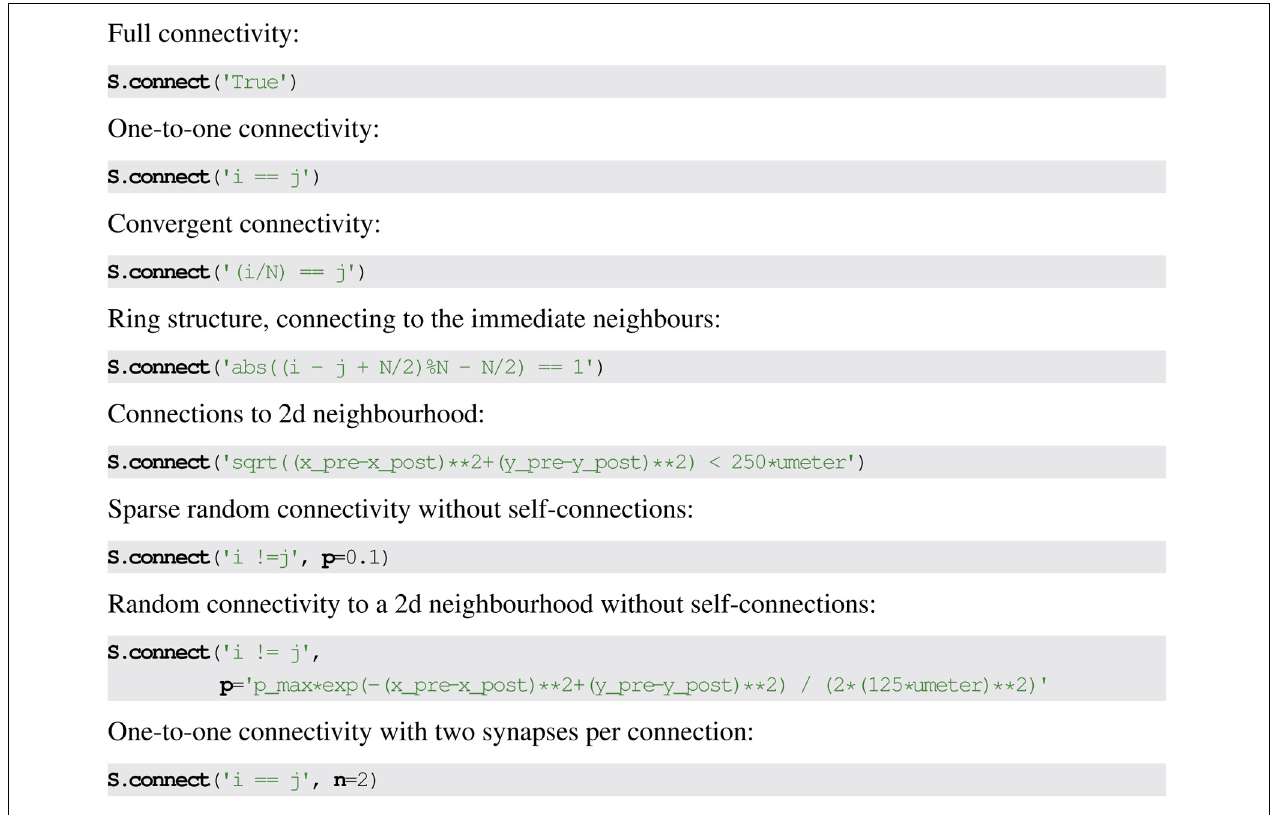
FIGURE 5 | Examples for synaptic connection descriptions in Brian2. Strings define conditions based on the pre-synaptic neuron index i , post-synaptic neuron index j , and pre- and post-synaptic neuron variables with